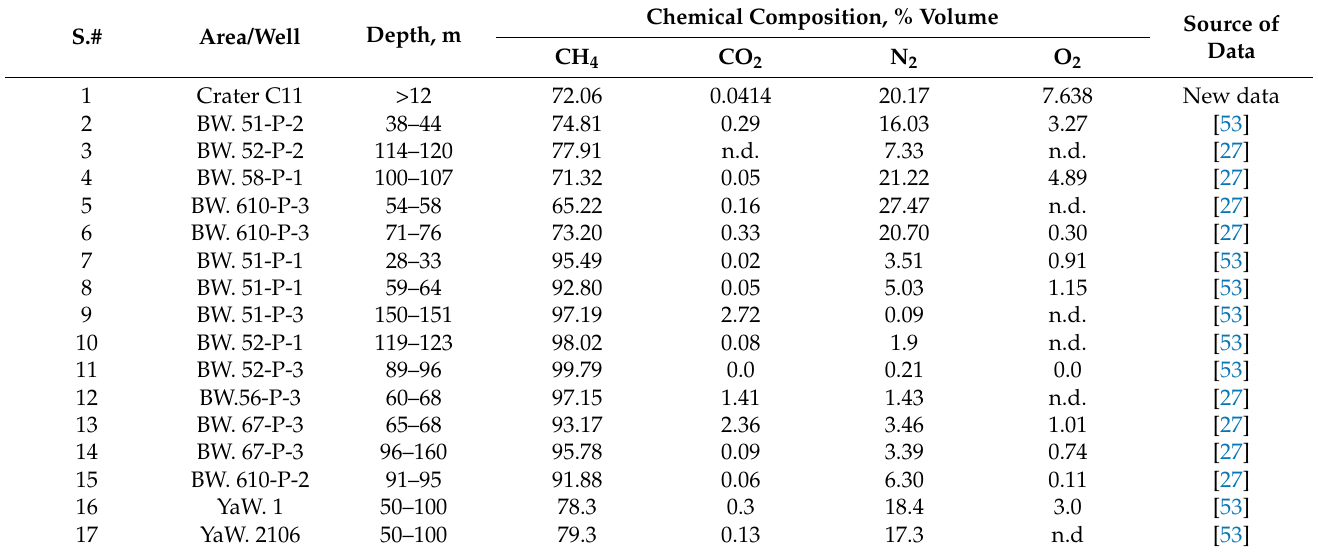
Table 3. Comparison of gas composition in samples from Seykha crater C11 (new data) and PF parametric wells from the Bovanenkovskoye and Yamburgskoye HC fields (according to